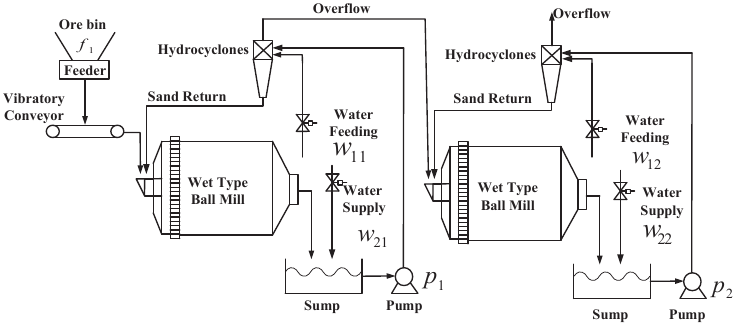
Figure 1. Flow chart of two-stage grinding